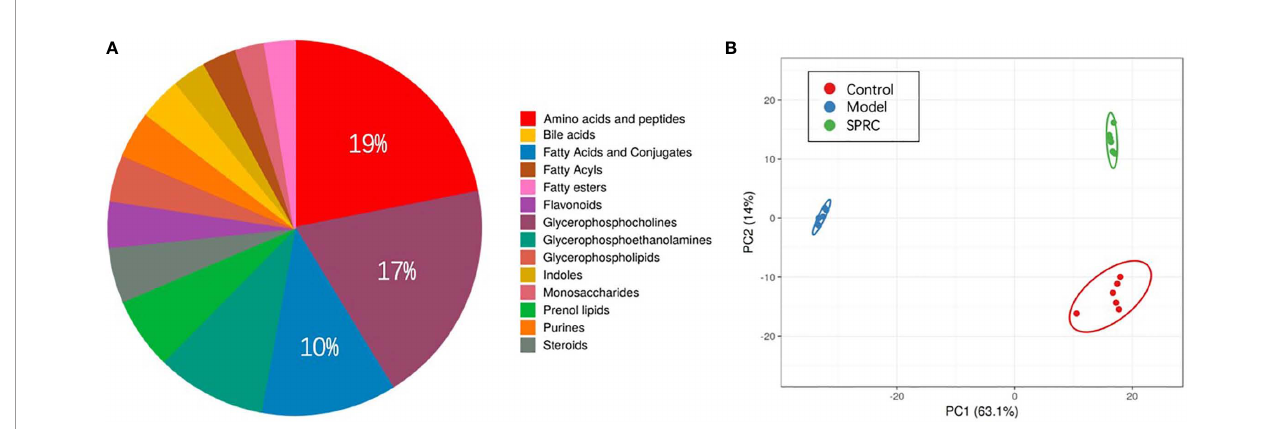
FIGURE 7 | Comparison of the metabolite pro fi les among groups. (A) Pie chart showing the contributions of different metabolite sets in plasma samples. Among all the metabolite sets, amino acids contributed the most (19%), followed by glycerophosphocholine (17%) and fatty acids and conjugates (10%). (B) Principal component analysis (PCA) score plot discriminating the metabolic pro fi les of the three groups. Each dot represents one rat plasma sample, and different colors represent rats from different groups. (R2X=0.77, Q2=0.697).